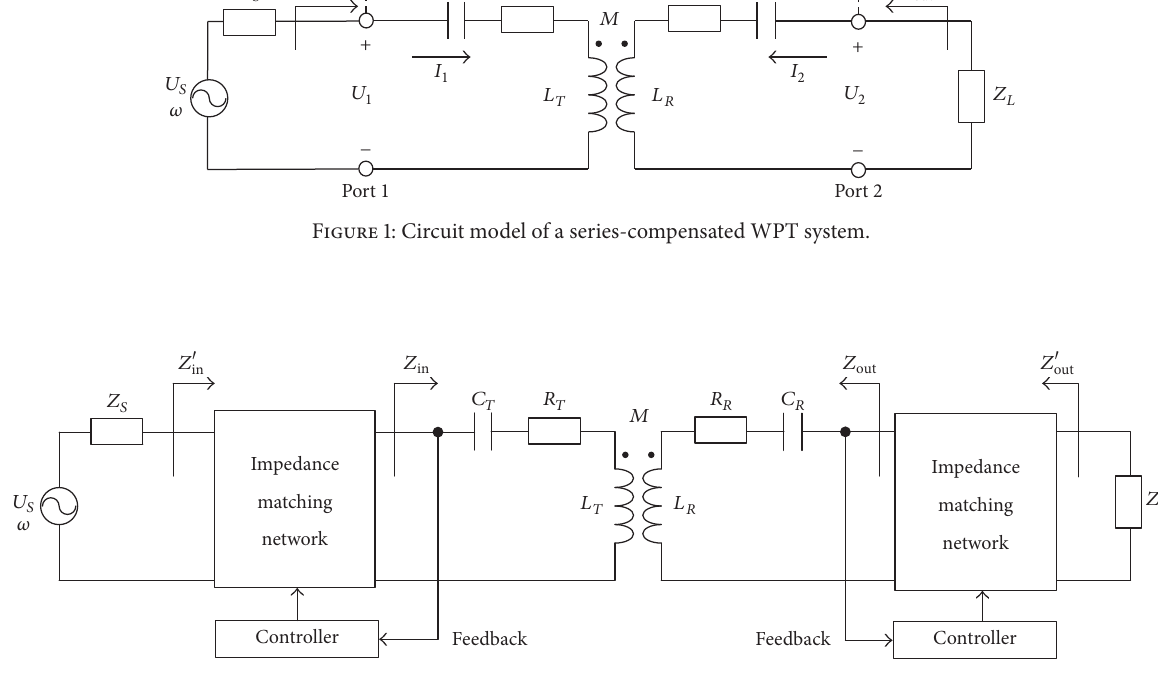
Figure 2: Traditional dual-side impedance-matching